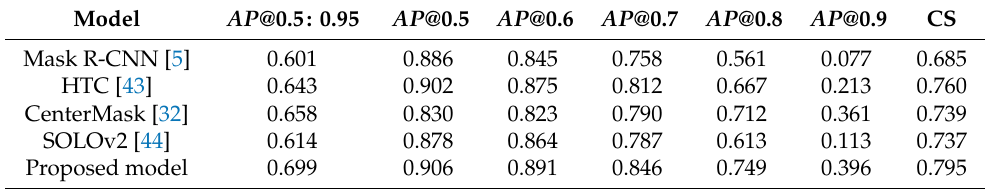
Table 7. Comparison results with different IoU thresholds. The best results are in bold. Model